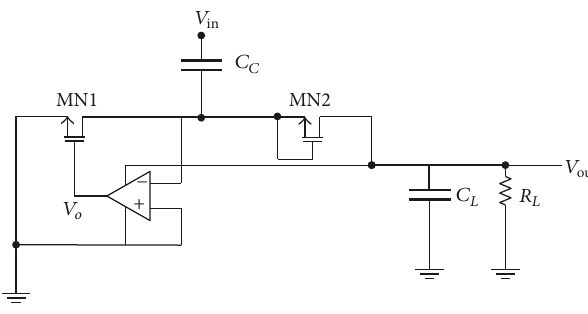
Figure 4: Proposed self-biased active voltage